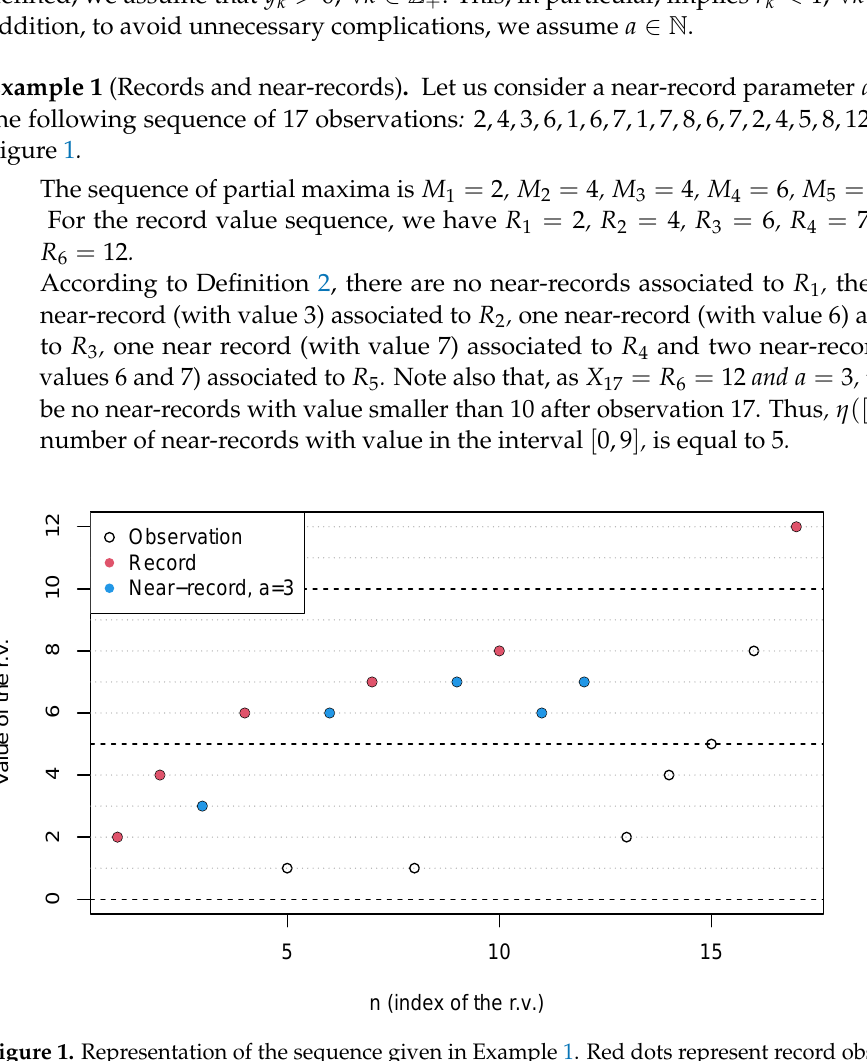
Figure 1. Representation of the sequence given in Example 1. Red dots represent record observations, while blue dots are near-record observations with parameter a =